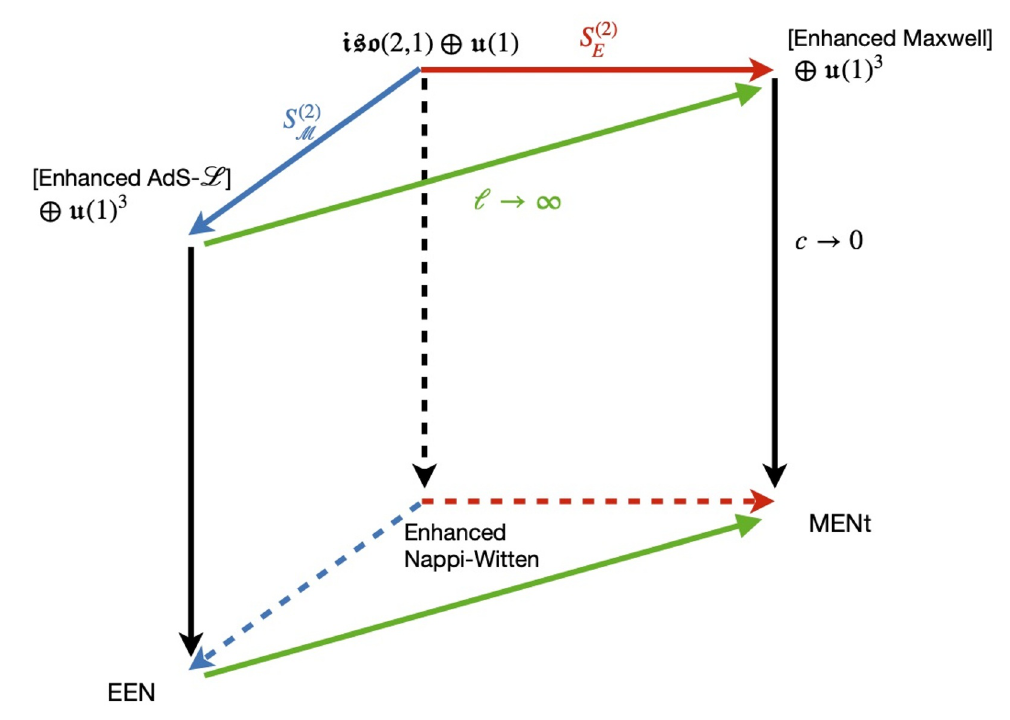
Figure 1 . Expansions and